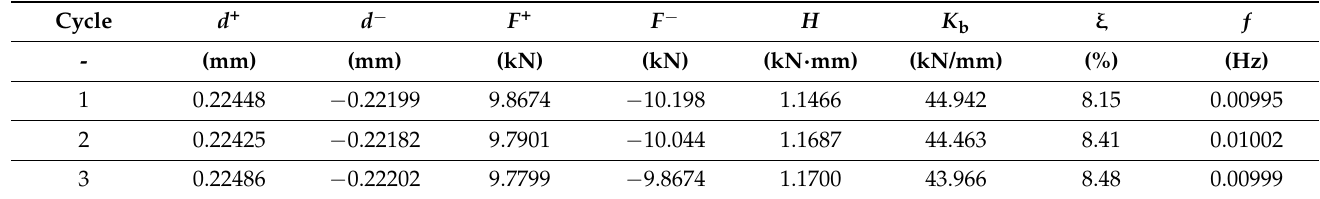
Table 2. Result data for force–displacement under tension and